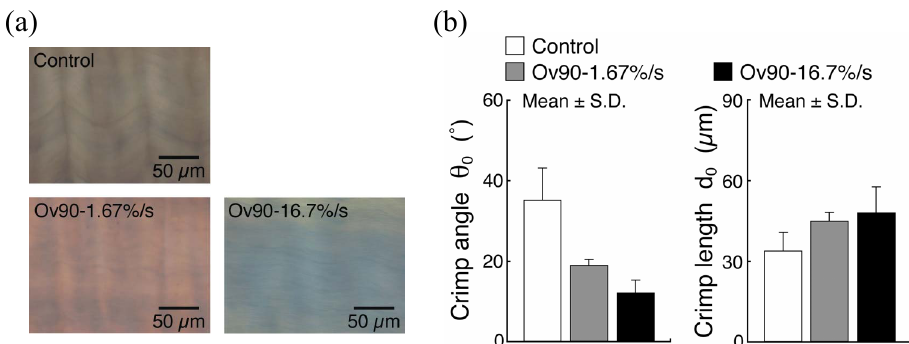
Fig. 5 Optical micrographs of crimp morphology (a) and the parameters expressing the morphology (b) of the control and overloaded specimens.